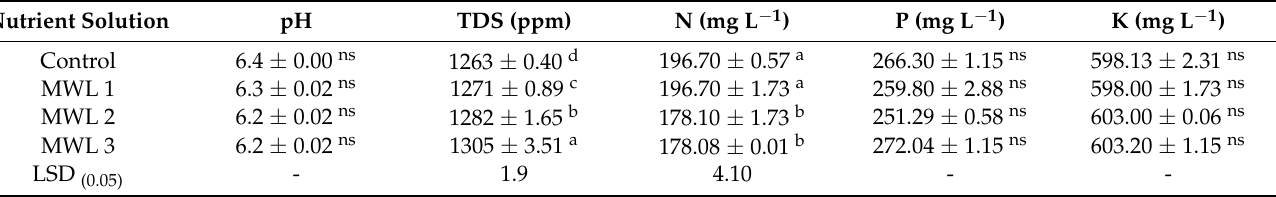
Table 4. Effects of different magnetic levels on pH, TDS, N, P, and K concentrations in the nutrient or fertigation solution; mean values and standard errors (SE) are